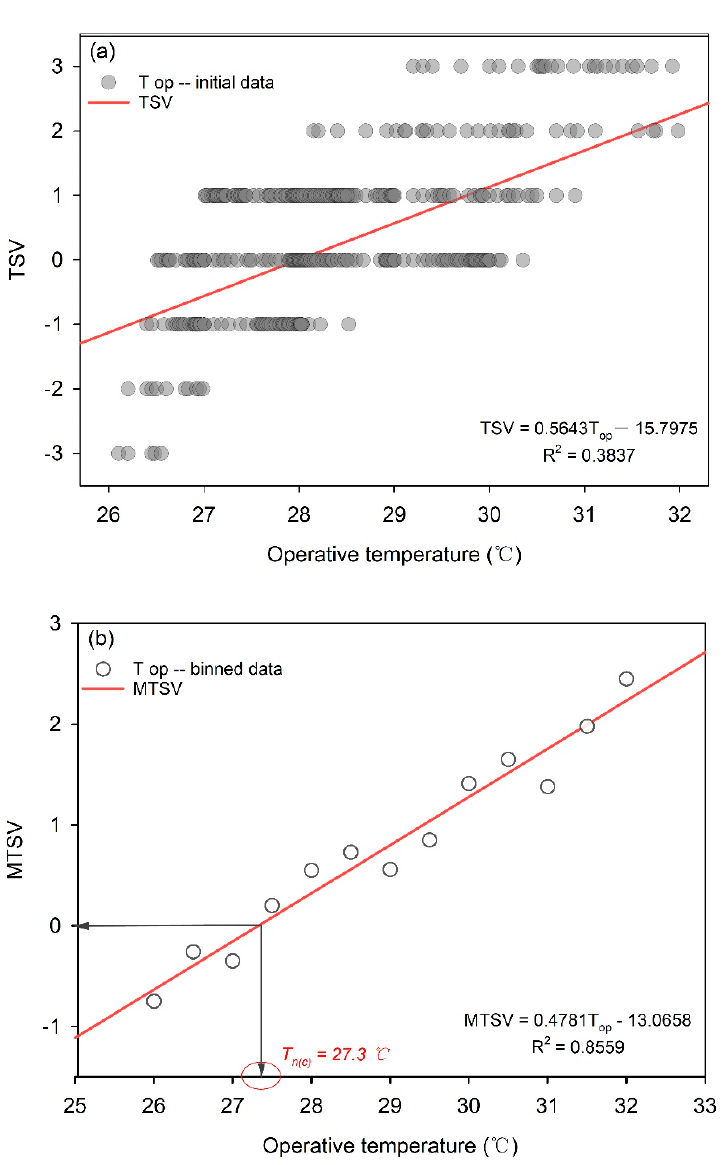
Figure 6. Regression analysis between operative temperature and thermal sensation vote: ( a ) initial data; ( b ) binned data.